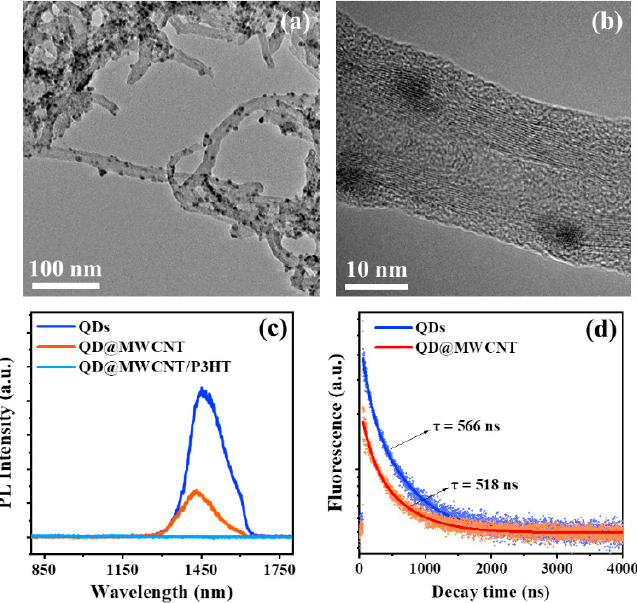
Figure 3. ( a ) TEM and ( b ) HRTEM images of PbS 0.75 Se 0.25 -QD@MWCNT. ( c ) PL spectra of PbS 0.75 Se 0.25 -QDs, PbS 0.75 Se 0.25 -QD@MWCNT and PbS 0.75 Se 0.25 -QD@MWCNT/P3HT. ( d ) Fluo- rescence decay of PbS 0.75 Se 0.25 -QDs and PbS 0.75 Se 0.25 -QD@MWCNT with fitted curves (solid